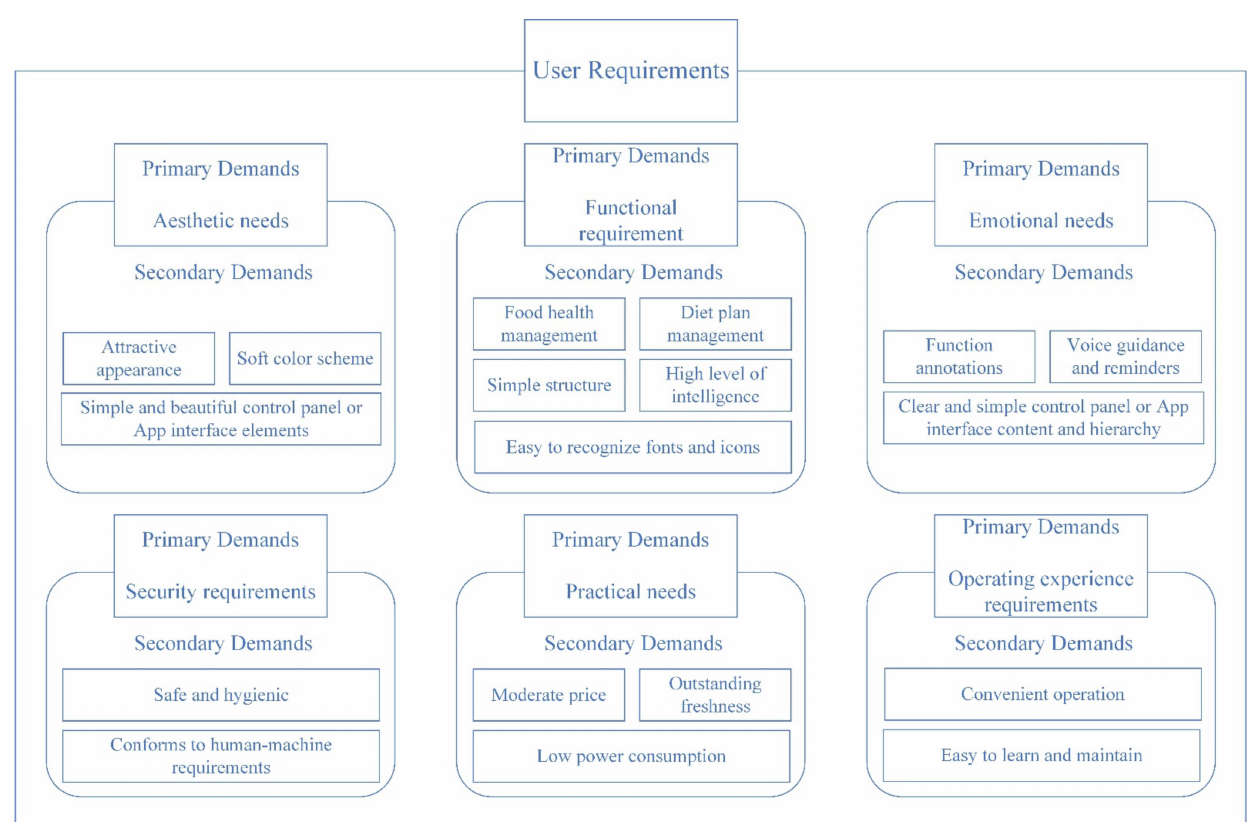
Figure 3. Collected user